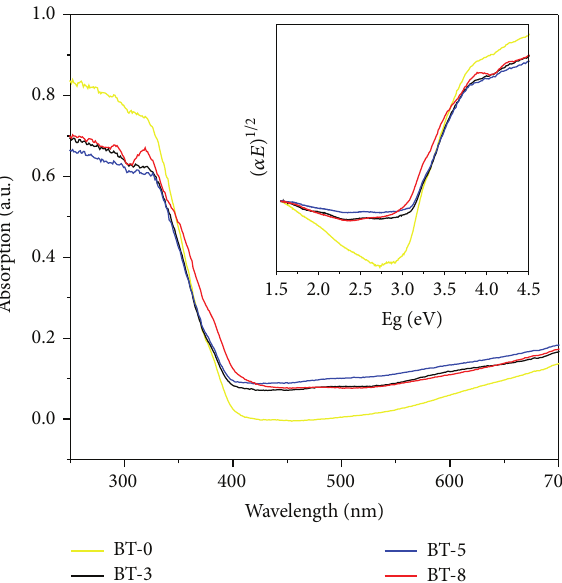
Figure 5: UV-vis spectra with different doping conditions.